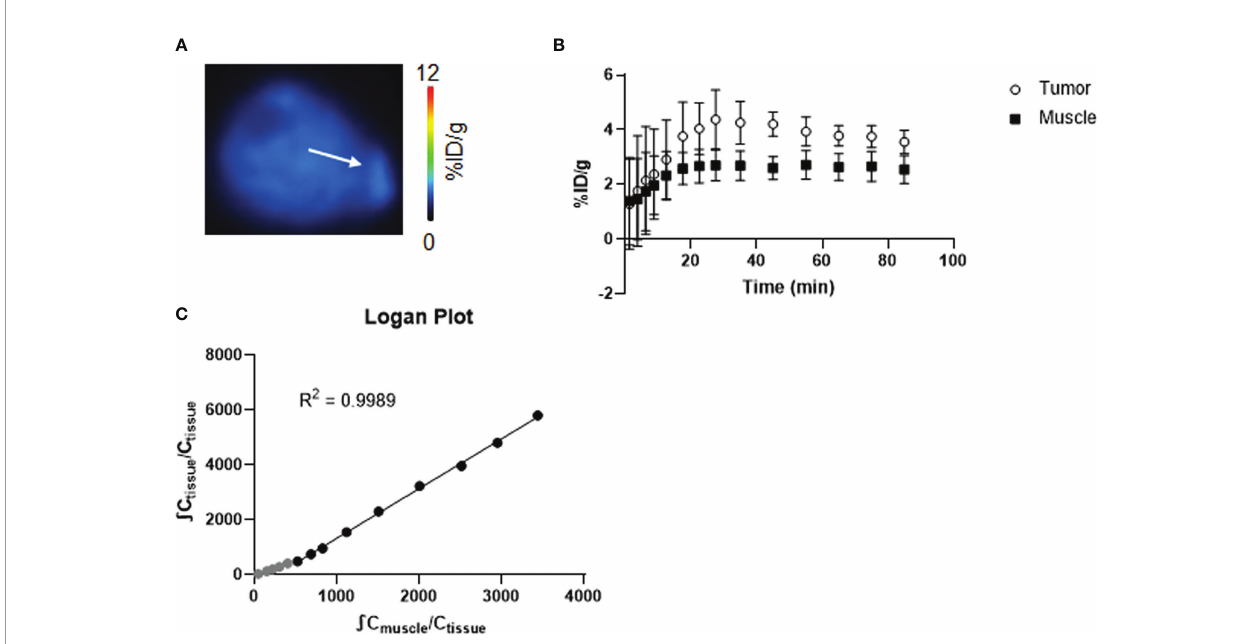
FIGURE 2 | Kinetic study of [ 18 F]4-FGln. (A) Coronal PET image summed from 15 to 50 min of dynamic scan of a representative JJN3 tumor-bearing mouse expressed as %ID/g. The white arrow indicates tumor. (B) Time-activity curves of the muscle and tumor of JJN3 tumor-bearing mice (n = 3). (C) Logan graphical analysis of TACs of JJN3 tumor-bearing mice. Data points used for the graphical fi ts are denoted in black, and unused data points are